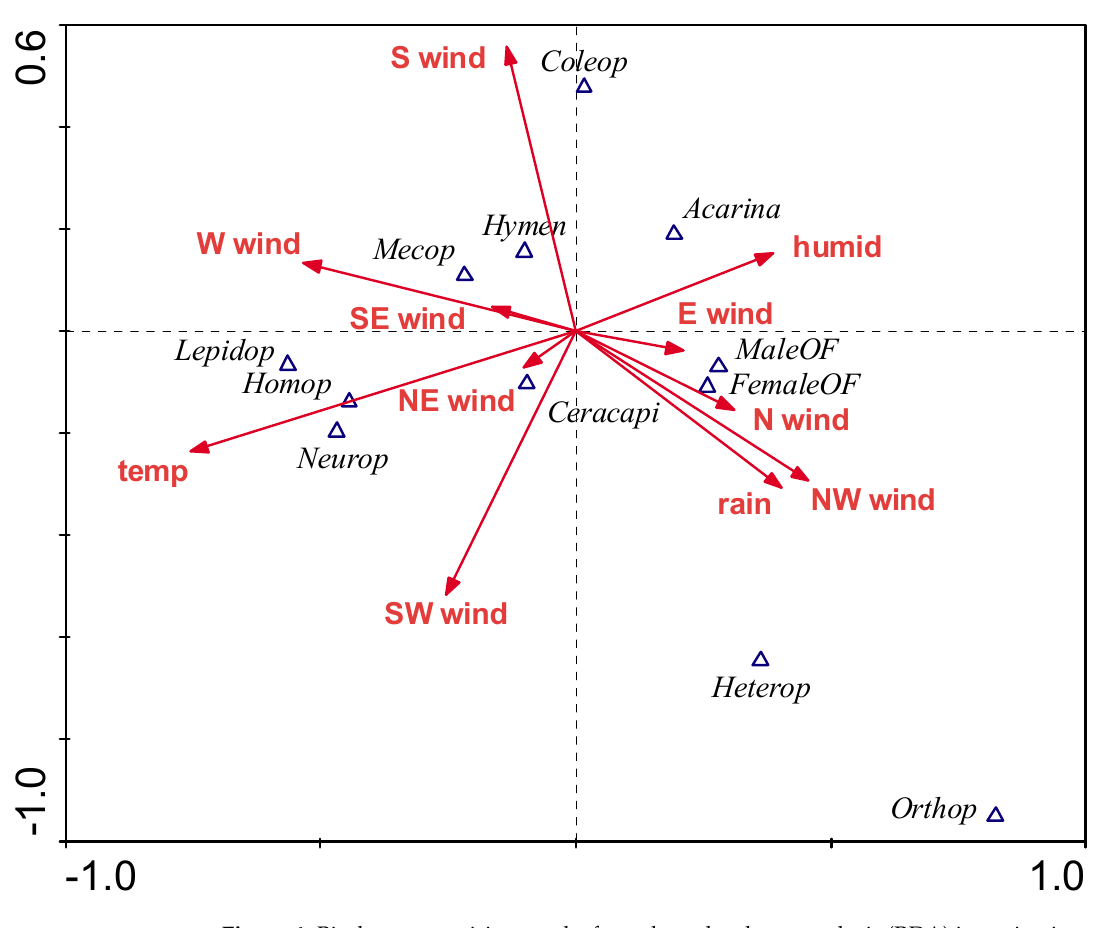
Figure 4. Bi-plot summarising results from the redundancy analysis (RDA) investigating associations between environmental parameters and the activity (number of animals recovered from McPhail traps) of different orders/species of invertebrates used to monitor olive fly activity in the experimental table olive orchards cv Kalamon used. Axis 1 explains 22.5% and axis 2 a further 7.6% of the variation. Arrows represent the environmental explanatory variables/drivers, and triangles represent the in- vertebrate orders and species response variables. Explanatory variables/drivers: Temp, temperature (F = 17.9; p = 0.002); rain, rainfall (F = 2.9; p = 0.026); humid, relative humidity (F = 2.7; p = 0.044); NW wind, northwest wind (F = 6.5, p = 0.002); E-wind, east wind (F = 6.0; p = 0.02), SW wind, southwest wind (F = 3.9, p = 0.04); S wind, south wind (F = 3.5; p = 0.028); W wind, west wind (F = 2.8; p = 0.044); SE wind, southeast wind (F = 2.3; p = 0.062), NE wind, northeast wind (F = 2.1; p = 0.060); N wind, north wind (F = 0.69; p = 0.592). Response variables: MaleOF, male olive flies; FemaleOF, female olive flies; Ceracapi, Mediterranean fruit flies ( Ceratitis capitata ); Acarina (mites and ticks); Coleop, Coleoptera (beetles); Heterop, Heteroptera (a group of families in the order Hemiptera, true bugs); Homop, Homoptera (suborder of the Hemiptera, true bugs); Hymen, Hymenoptera (parasitic wasp families of the order); Lepidop, Lepidoptera (butterflies and moths); Mecop, Mecoptera (Sorpionflies); Neurop, Neuroptera (net-winged insects); Orthoptera (grasshoppers, locusts, and